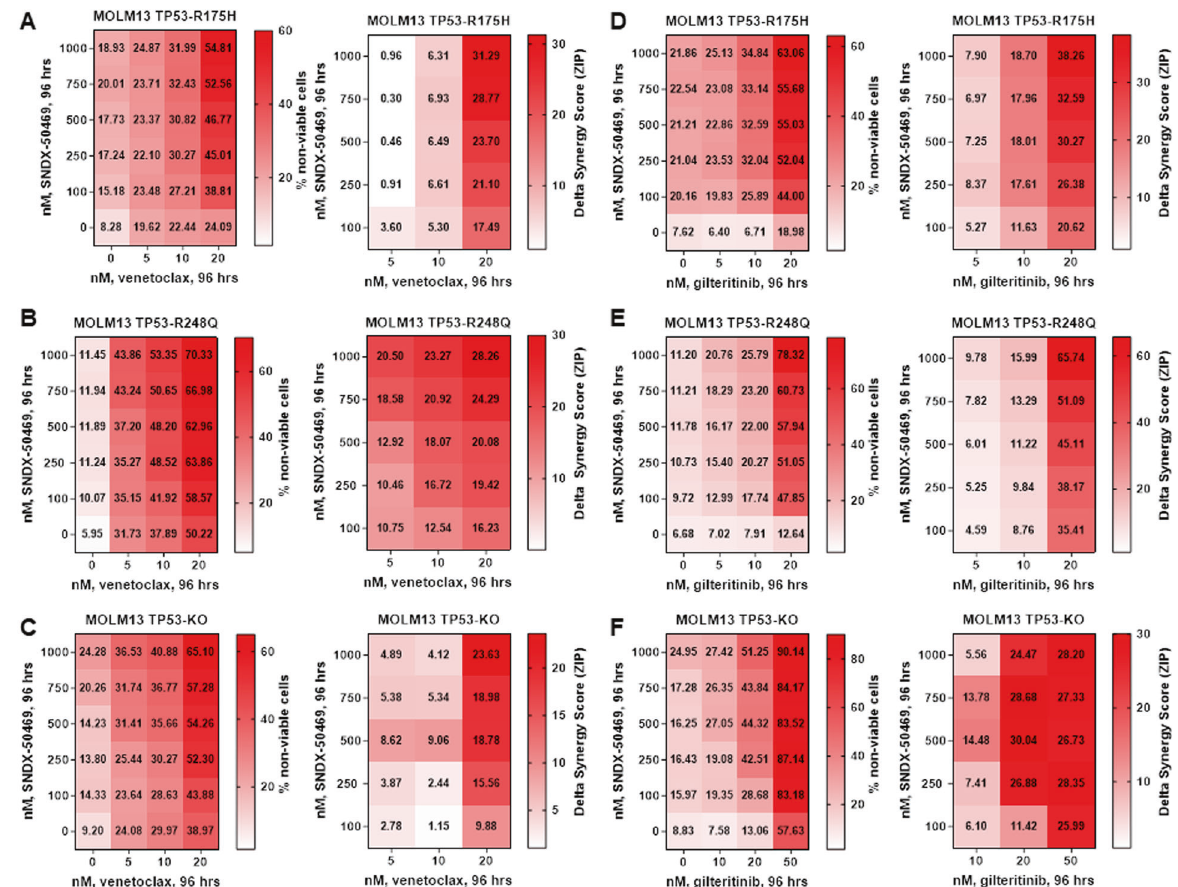
Fig. 6 Co-treatment with Menin inhibitor and venetoclax or FLT3 inhibitor gilteritinib induces synergistic in vitro lethality in MOLM13 cells with isogenic TP53 mutations or TP53 knockout. A – C MOLM13 TP53-R175H, MOLM13 TP53-R248Q, and MOLM13 TP53 − / − cells were treated with the indicated concentrations of SNDX-50469 and/or venetoclax for 96 h. At the end of treatment, the % non-viable cells were determined by staining with TO-PRO-3 iodide and fl ow cytometry analysis. Delta synergy scores were calculated by the ZIP method. Synergy scores > 1.0 indicate a synergistic interaction of the two agents in the combination. D – F MOLM13 TP53-R175H, MOLM13 TP53-R248Q, and MOLM13 TP53 − / − cells were treated with the indicated concentrations of SNDX-50469 and/or gilteritinib for 96 h. At the end of treatment, the % non-viable cells were determined by staining with TO-PRO-3 iodide and fl ow cytometry analysis. Delta synergy scores were determined by the ZIP method. Synergy scores > 1.0 indicate a synergistic interaction of the two agents in the